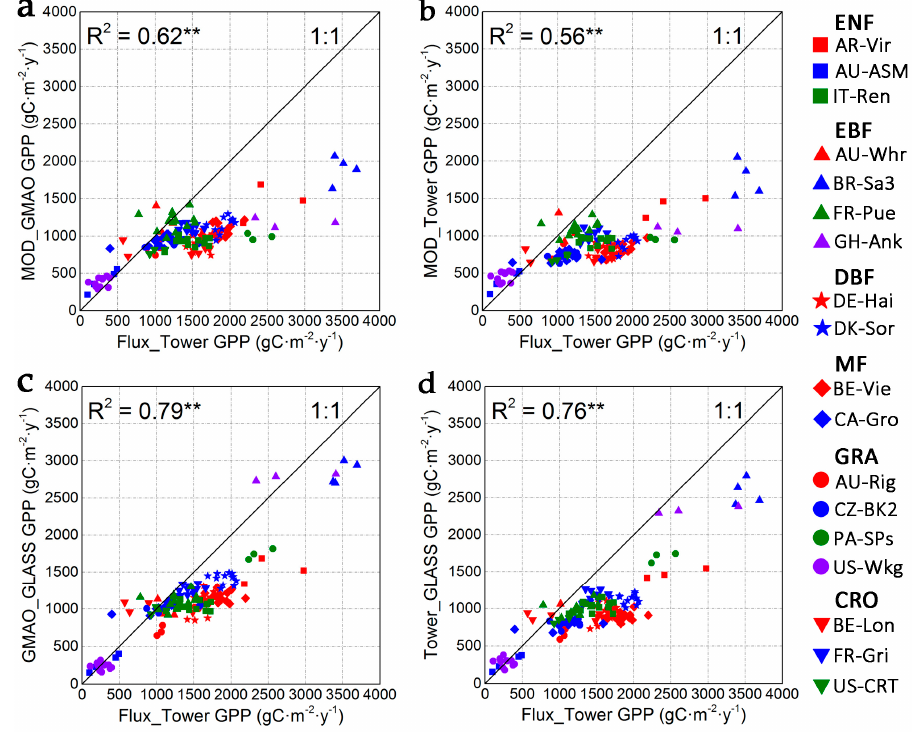
Figure 3. Comparisons of the annual Flux_Tower GPP with: ( a ) MOD_GMAO GPP; ( b ) MOD_Tower GPP; ( c ) GMAO_GLASS GPP; and ( d ) Tower_GLASS GPP. Significance levels: ** p < 0.01.